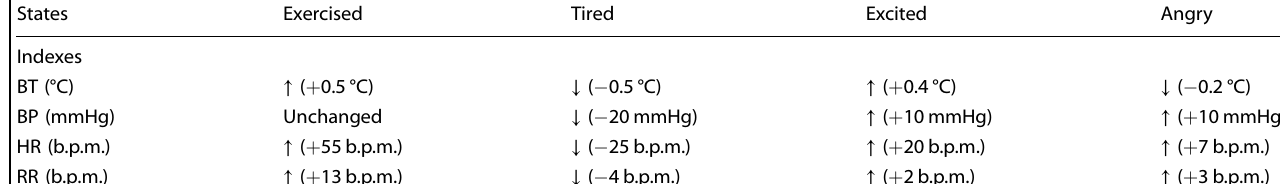
Table 1. Listing on the changes of four human vital signs under the different body states. States Exercised Tired Excited